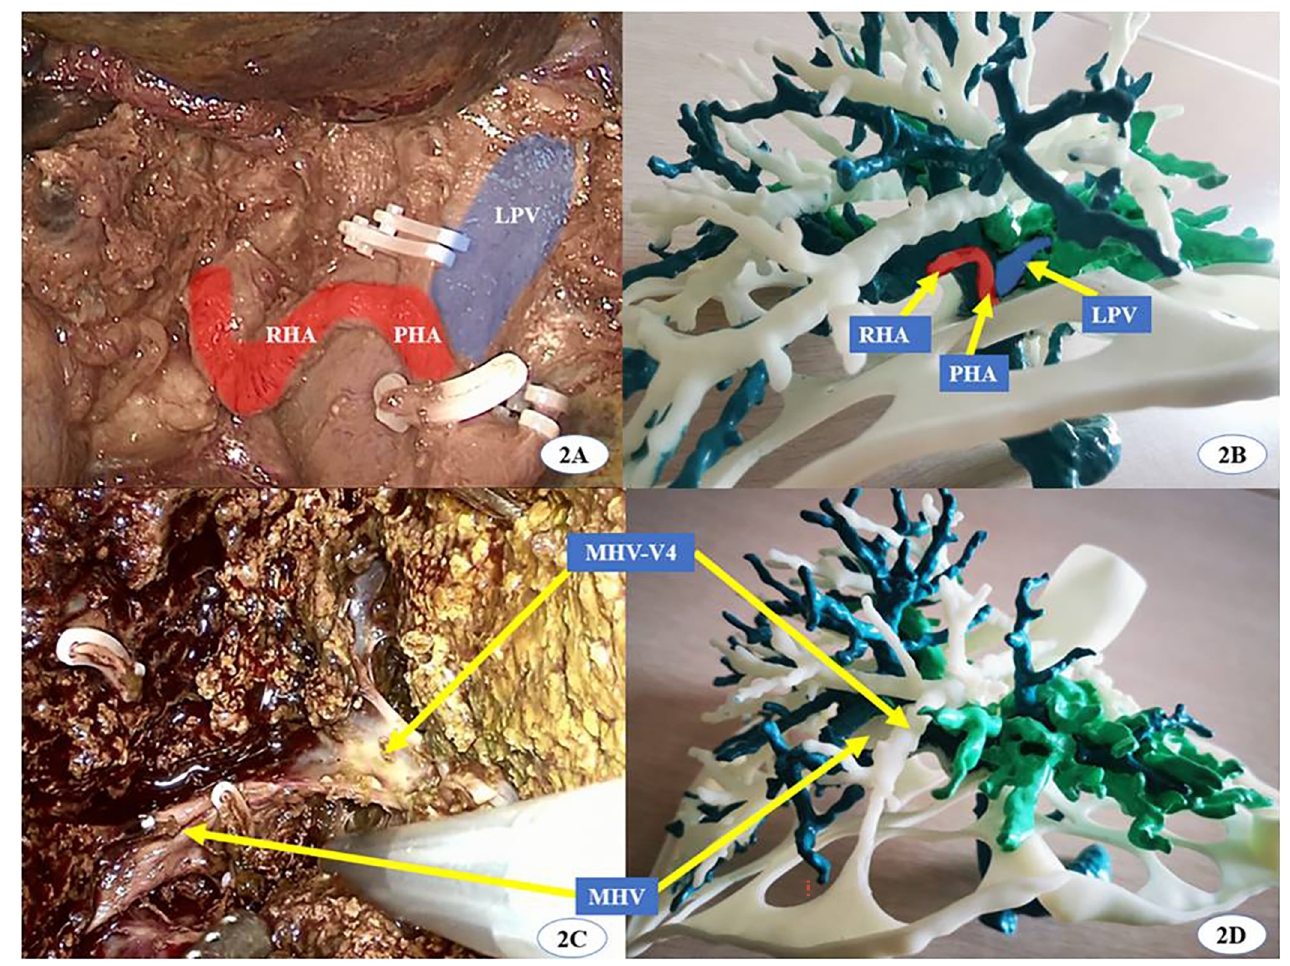
Fig 2. A modified 3D printing liver model of hilar cholangiocarcinoma was applied in intraoperative navigation. (RHA: right hepatic artery, PHA: proper hepatic artery, LPV: left portal vein, MHV: middle hepatic vein, MHV-V4: The venous reflux of hepatic segment 4 to MHV).